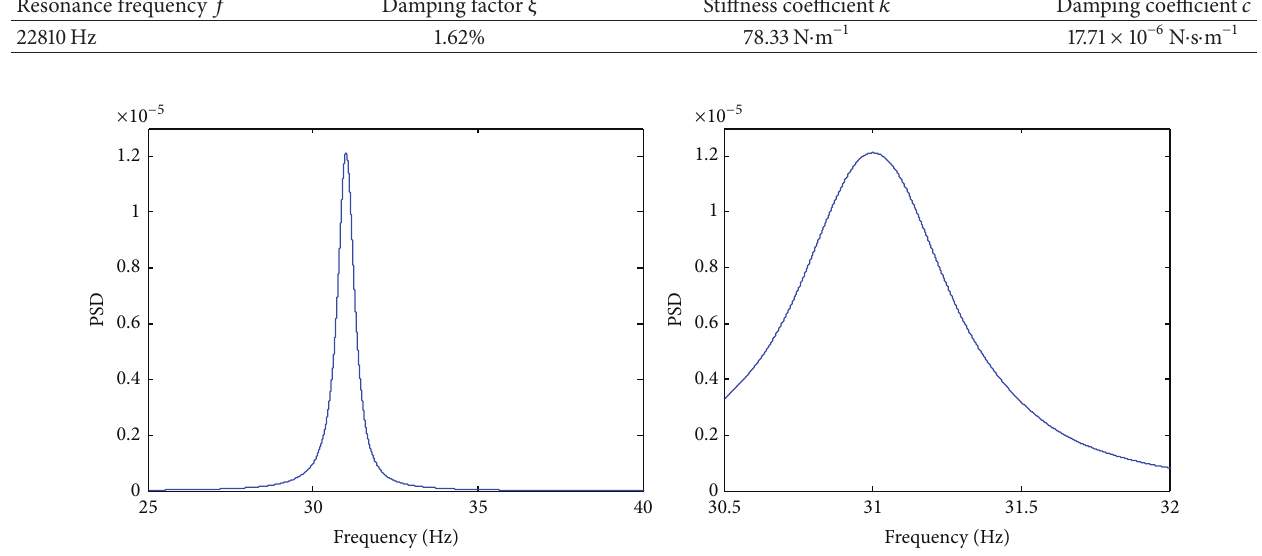
Figure 2: Spectrum for the two-DOF system.